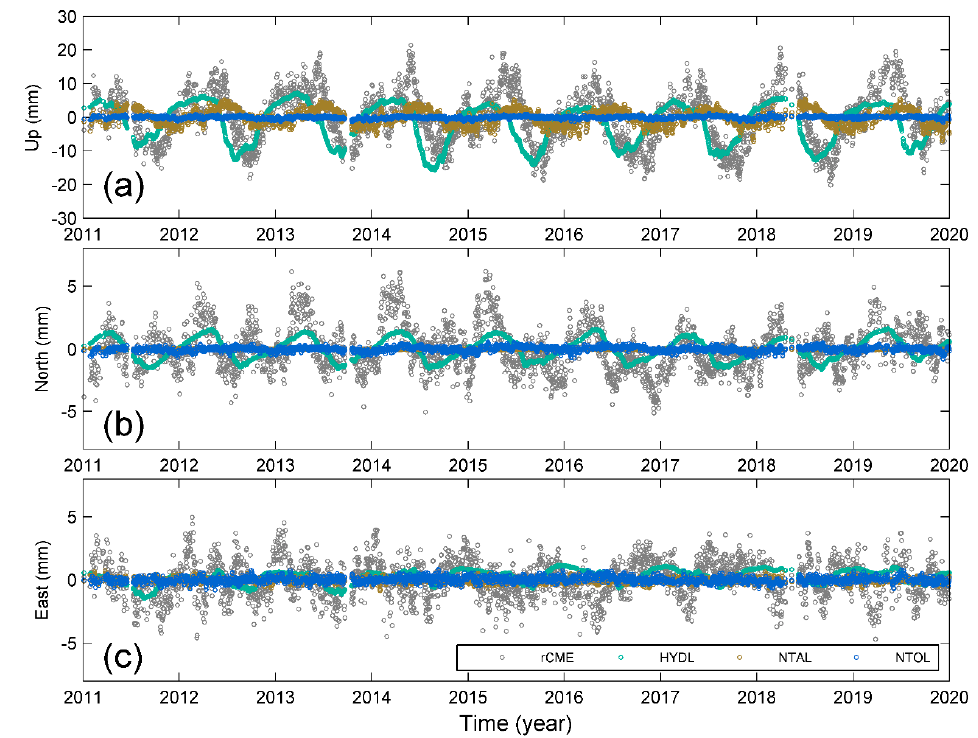
Figure 7. Comparison between rCMEs and loading deformations in response to HYDL, NTAL, and NTOL for ( a ) up, ( b ) north, and ( c ) east components, respectively. The open circles in gray, cyan, yellow and blue denote rCME, HYDL, NTAL and NTOL, respectively. Table 2. Variances of the detrended GPS time series corrected with rCMEs and oCMEs.